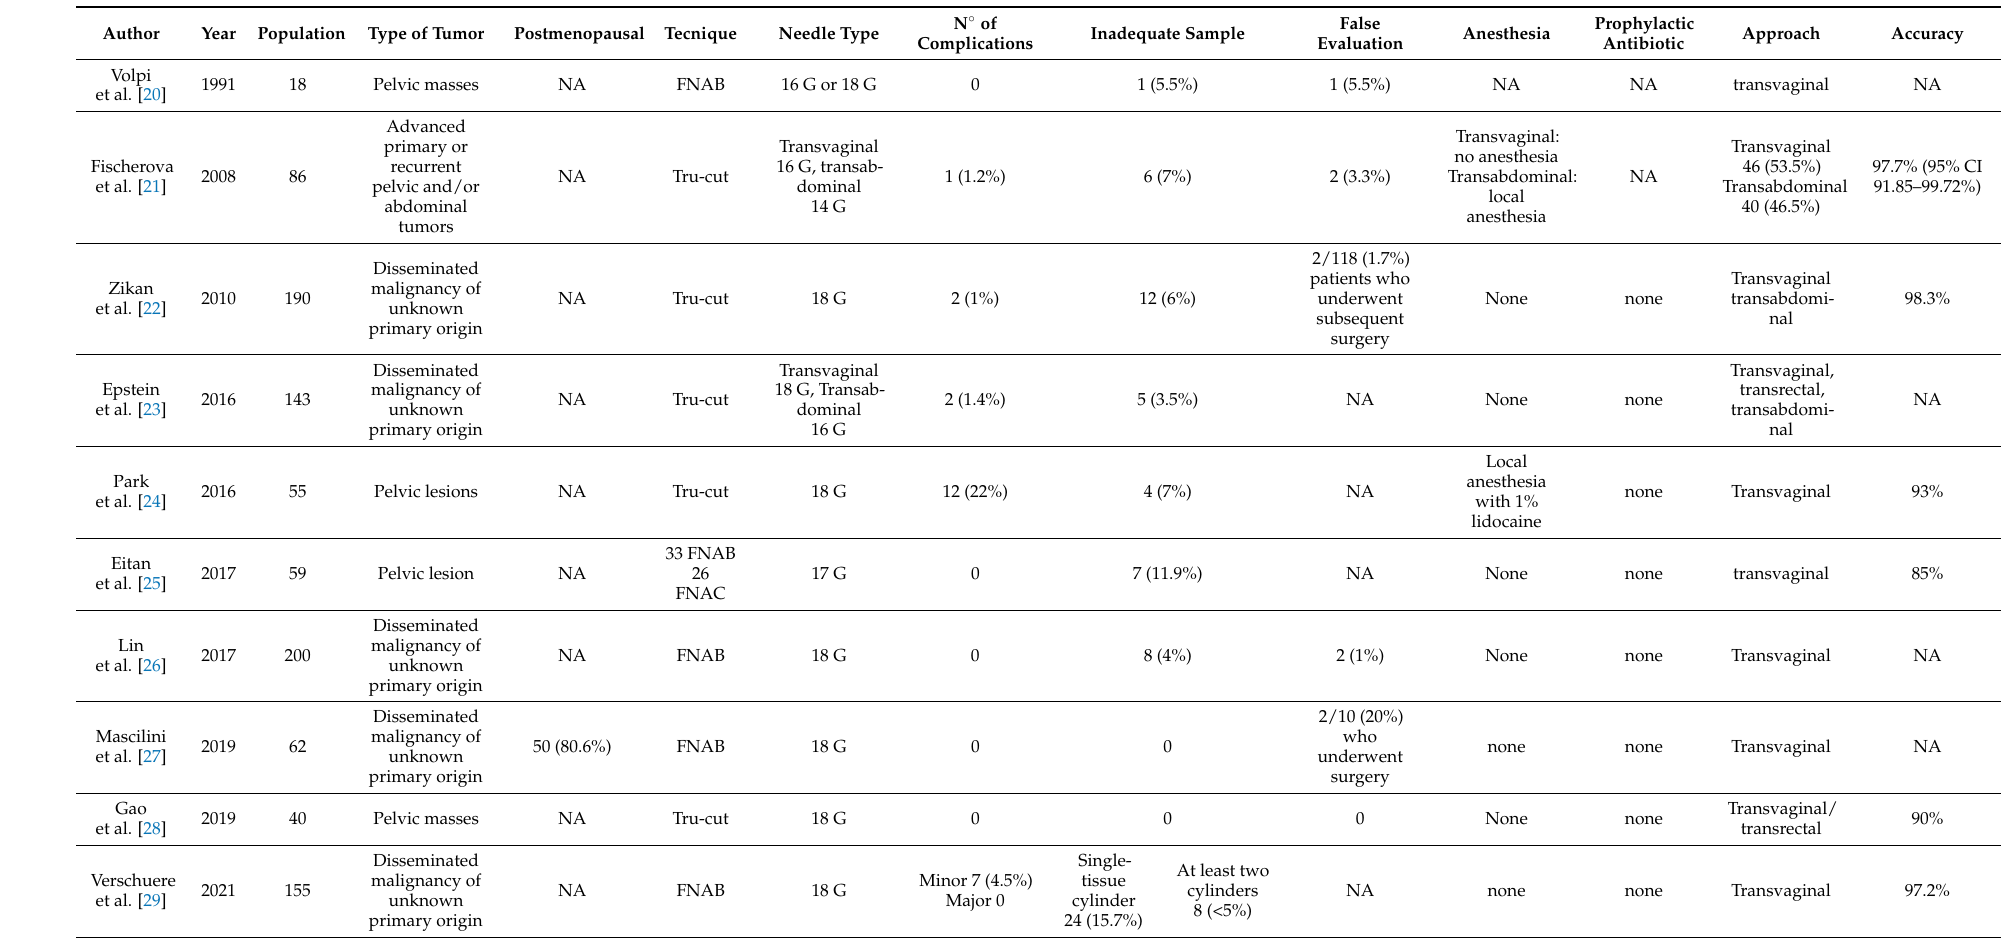
FNAB: Fine Needle Aspiration Biopsy; FNAC: Fine Needle Aspiration